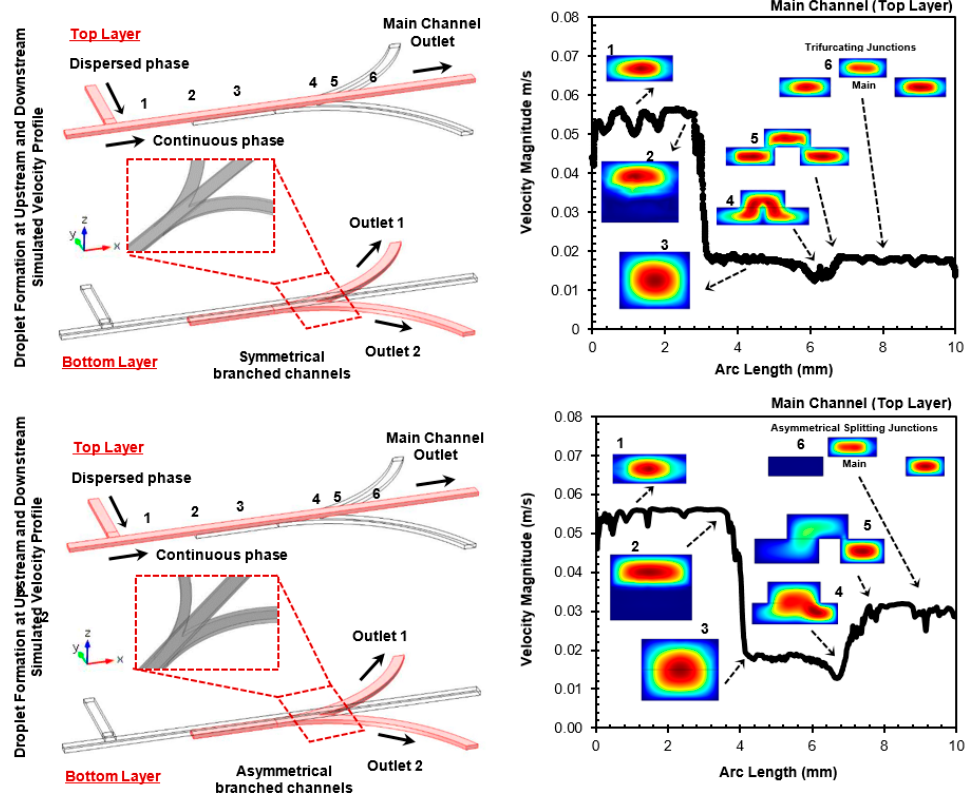
Figure 6. Evolution of flow profile at the upstream T-Junction and downstream of symmetrical and asymmetrical splitting junctions (for system: Q c = 2 mL/h).